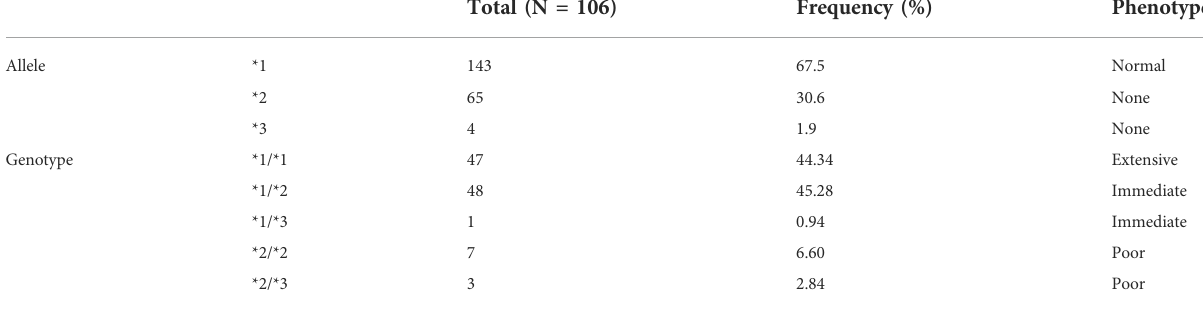
TABLE 2 Allele and Genotype frequencies of CYP2C19.